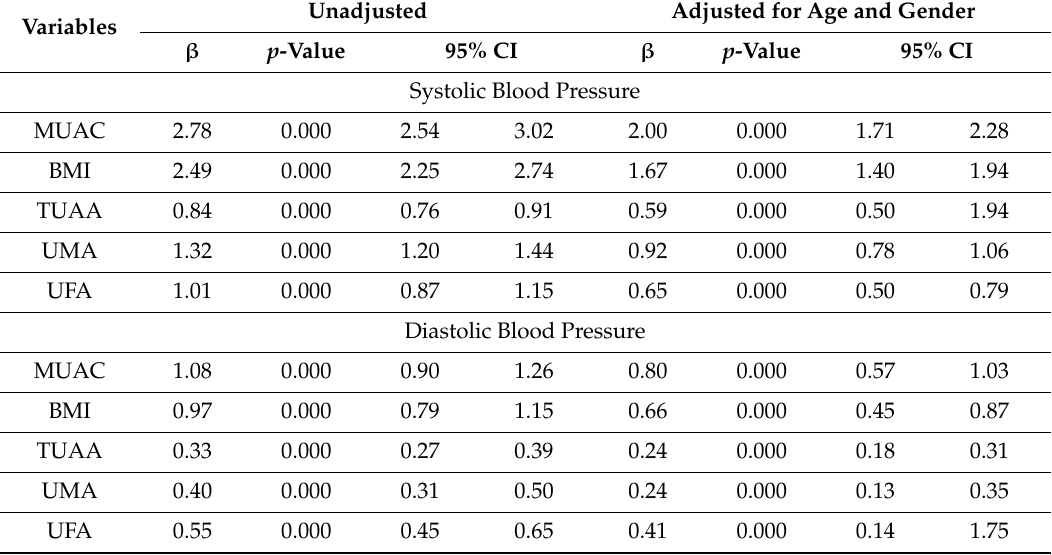
Table 2. Linear regression (beta, p -value and 95% confidence interval) for the association between blood pressure and under-nutrition variables of Ellisras children aged 9–17 years. Unadjusted Adjusted for Age and Gender Variables β p -Value 95% CI β p -Value 95% CI Systolic Blood Pressure